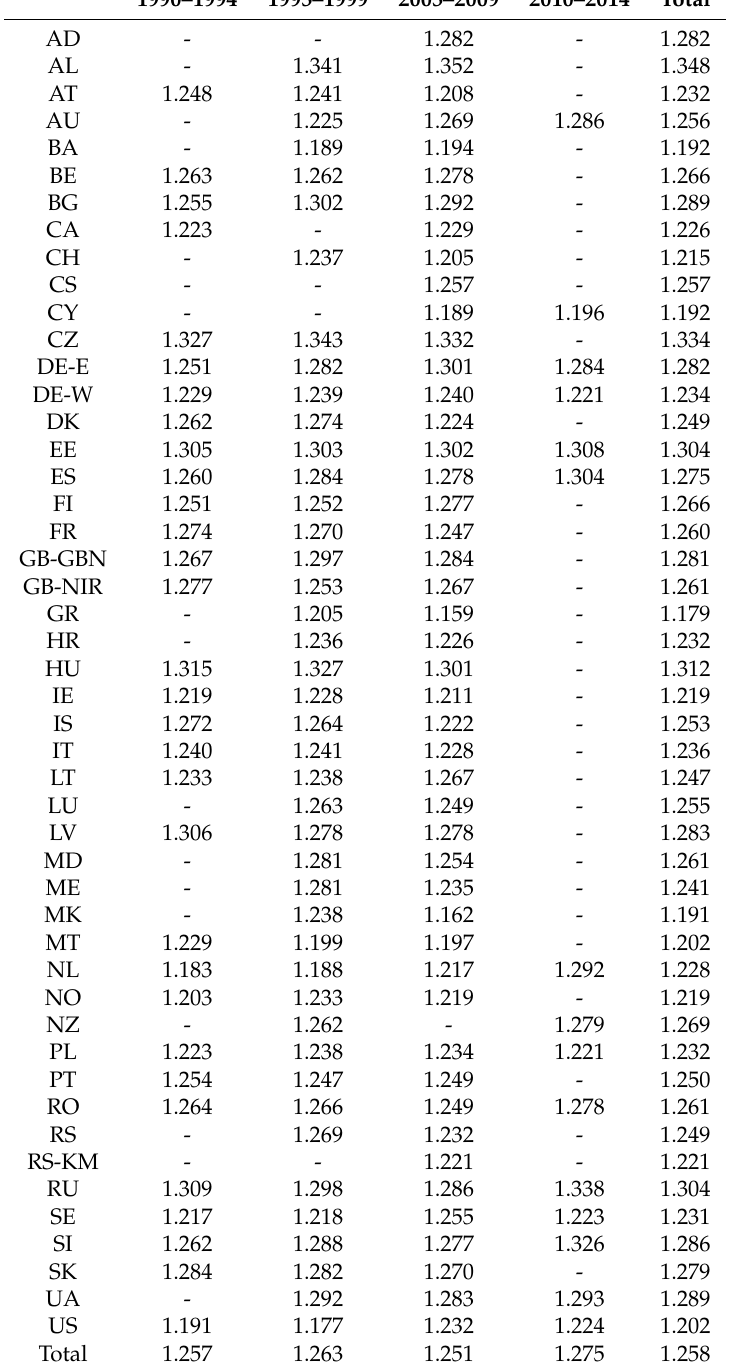
Table A3. The mean of the relative importance of family by country and